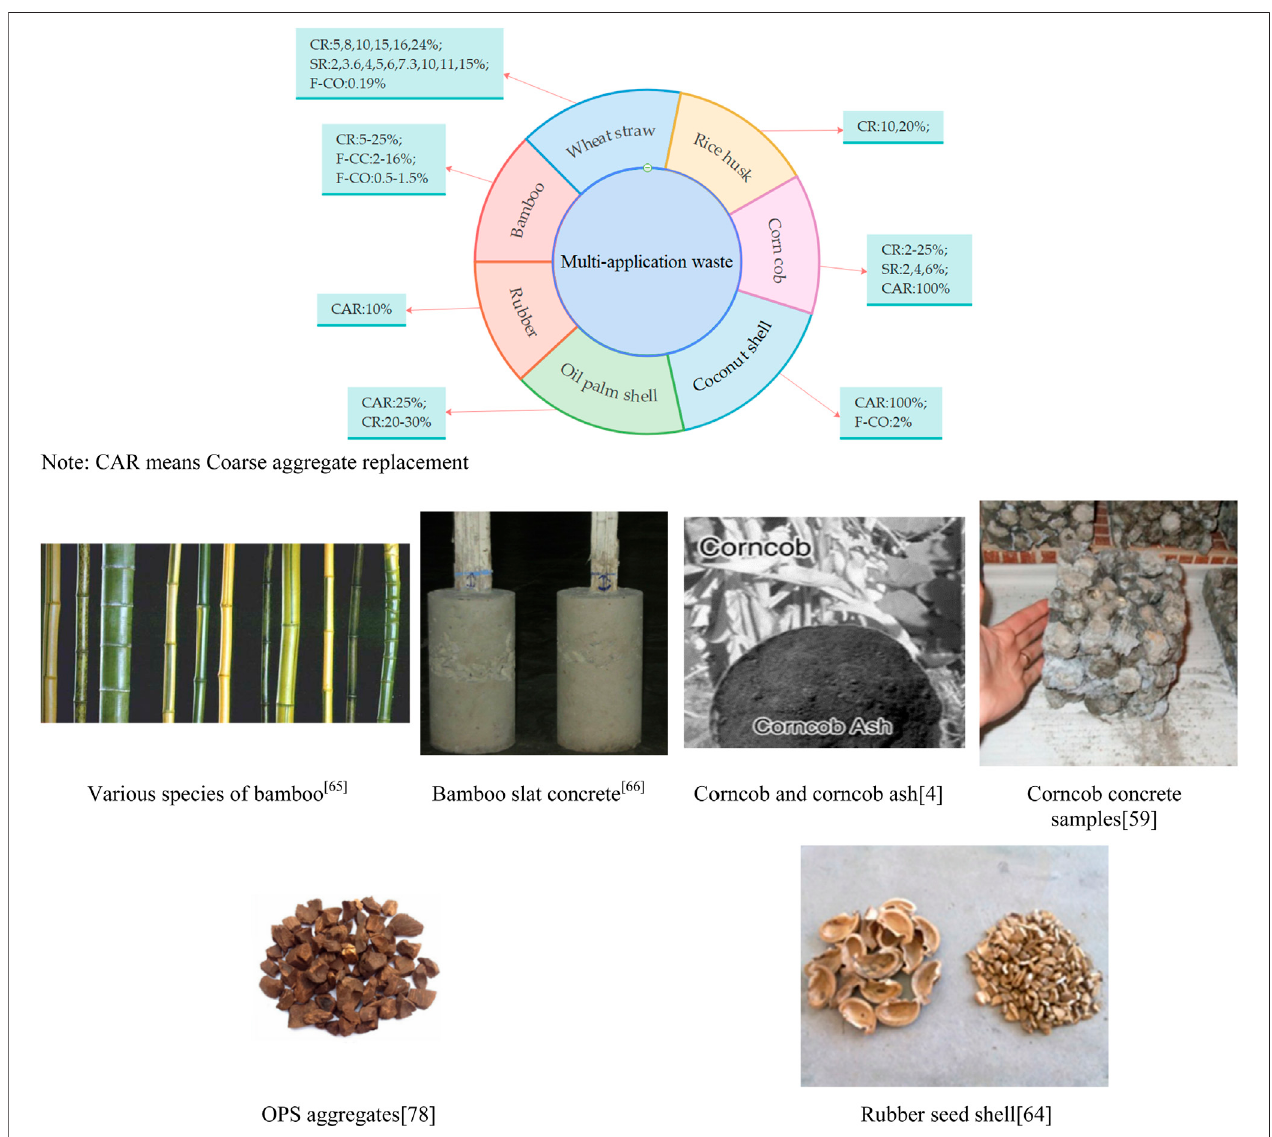
FIGURE 7 | Substitution and mixing amount of multi-application waste in concrete in other literatures.